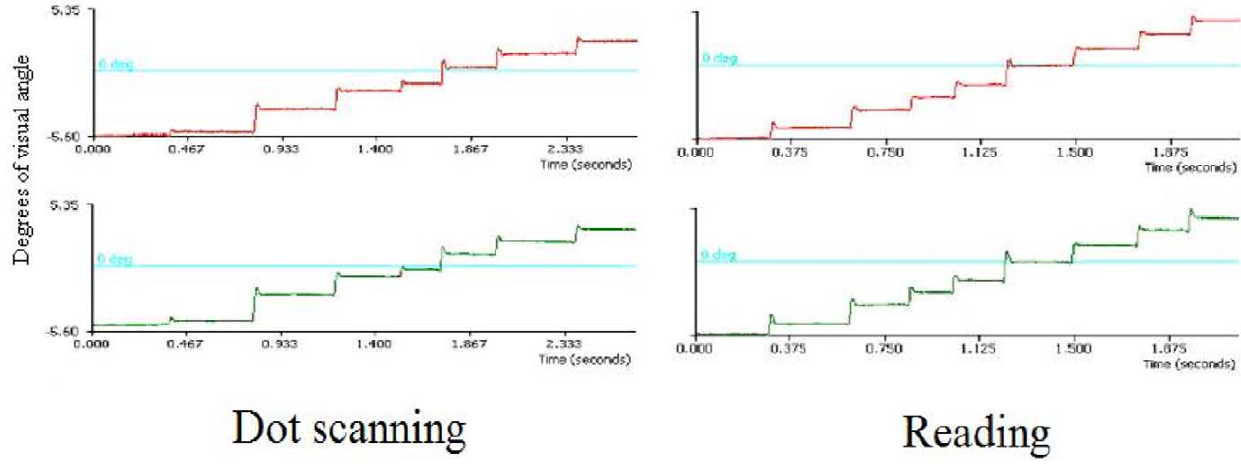
Figure 3. Raw eye movement data showing the typical ‘‘step-like’’ pattern of eye movements during the dot scanning and reading experiment. Horizontal axes represent trial duration in seconds. Vertical axes represent degrees of visual angle.